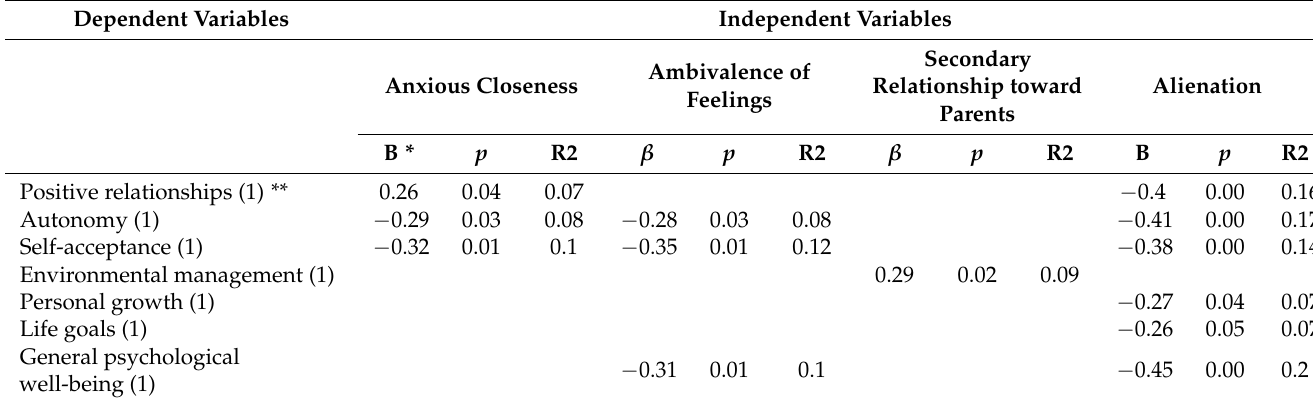
Table 2. Middle-aged women with a triple load’s types of relations with parents as predictors of their psycho-emotional health ( n = 61). Dependent